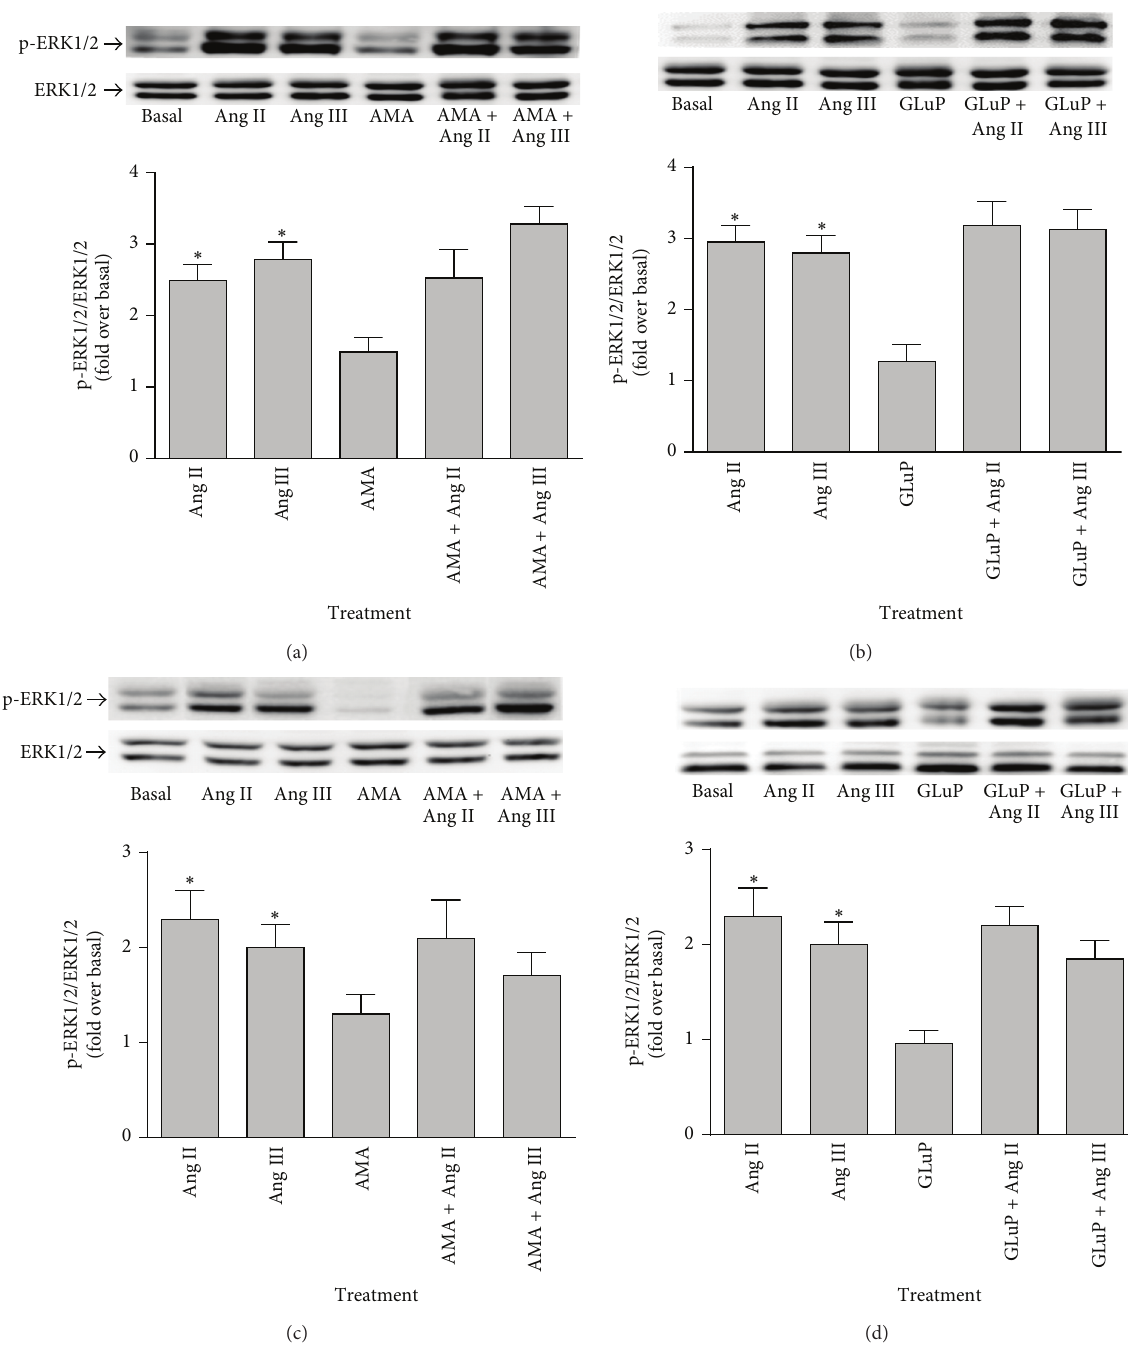
Figure 1: Effect of AMA and GluP on Ang II- and Ang III-induced ERK1/2 protein phosphorylation. Quiescent monolayers of brainstem ((a) and (b)) or cerebellum ((c) and (d)) astrocytes were pretreated with 10 𝜇 M AMA or 100 𝜇 M GluP for 15 minutes. The cells were subsequently stimulated with 100nM Ang II or 100nM Ang III for 10 minutes. Phosphorylated-ERK1/2 immunoreactive protein levels were measured by Western blot analysis using an antibody specific for the phosphorylated form of ERK1/2. Protein loading was quantified using the ERK1/2 protein antibody. The data were analyzed by densitometry, and the amount of phosphorylation was calculated as the fold increase over basal in the presence of vehicle. Each value represents the mean ± SEM of preparations of brainstem and cerebellum astrocytes from 6 or more litters of neonatal rat pups. ∗ denotes that 𝑃 < 0.05 as compared to basal levels for ERK1/2 expression in astrocytes prepared from the brainstem and the